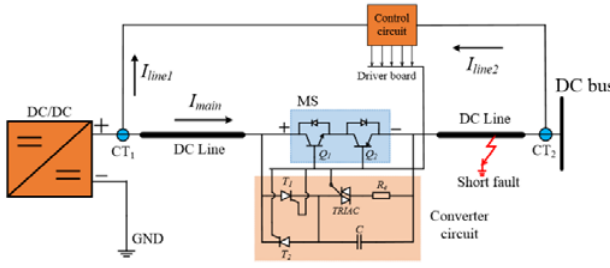
Figure 2. Typical topology of the bidirectional short-circuit current blocker (BSCCB) in DC microgrid.